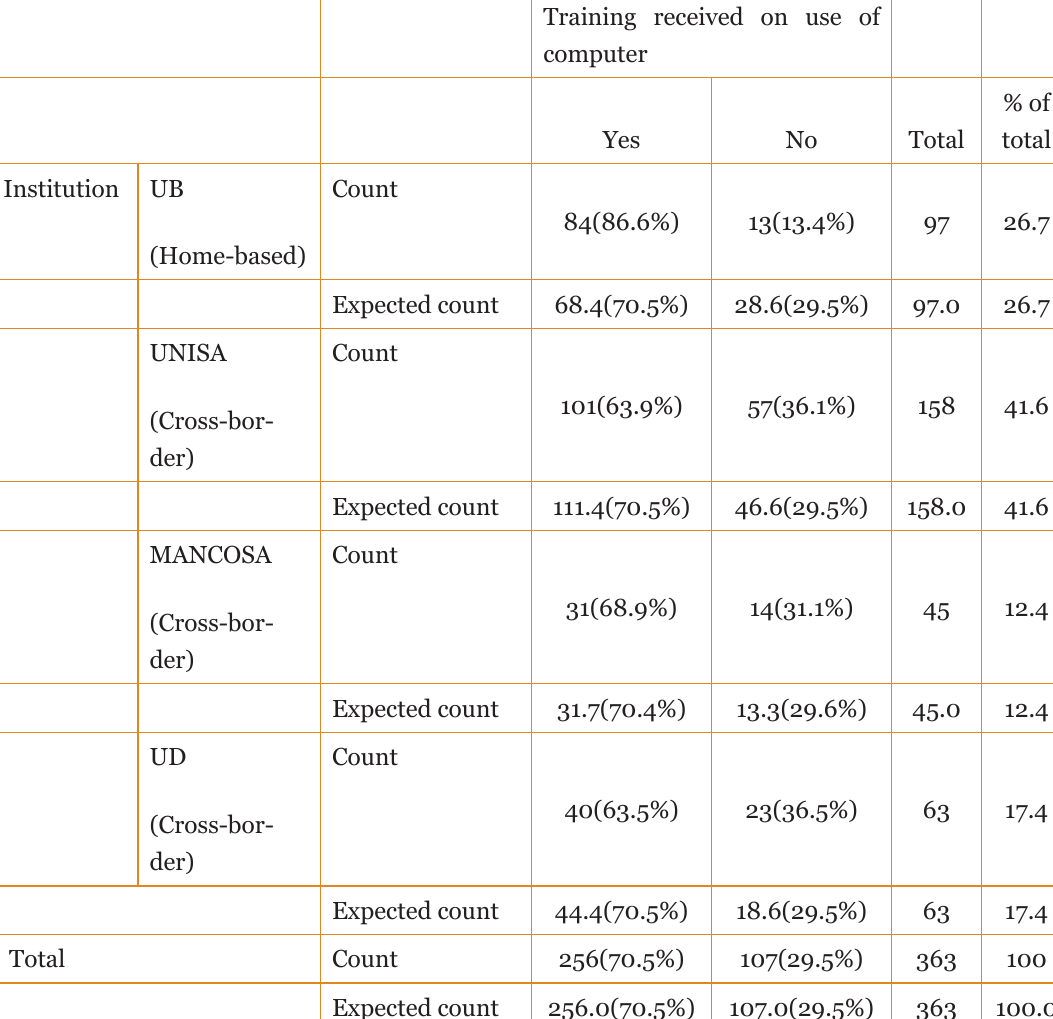
Institution – Did/Do you Receive any Training on the Use of a